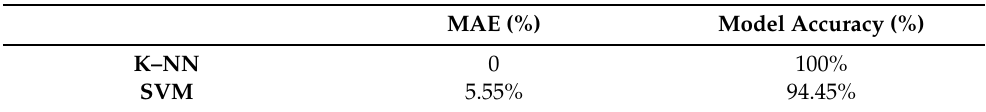
Table 7. Detection performance of the two classification models, in terms of Mean Absolute Error (MAE) and Average Model